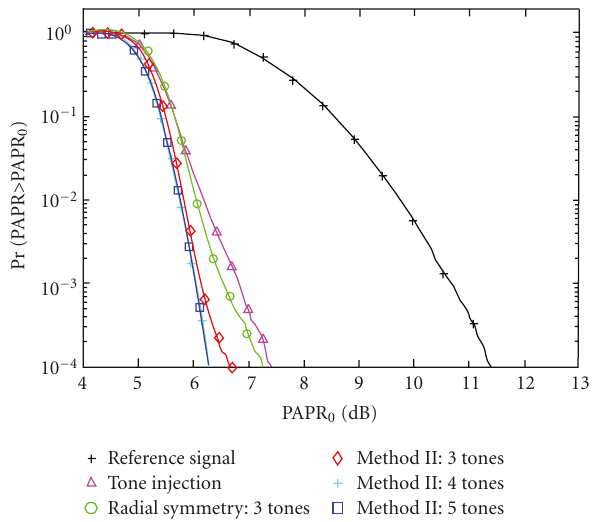
Figure 7: Method II: CCDF of OFDM system with 64 tones and 16-ary QAM modulation (with